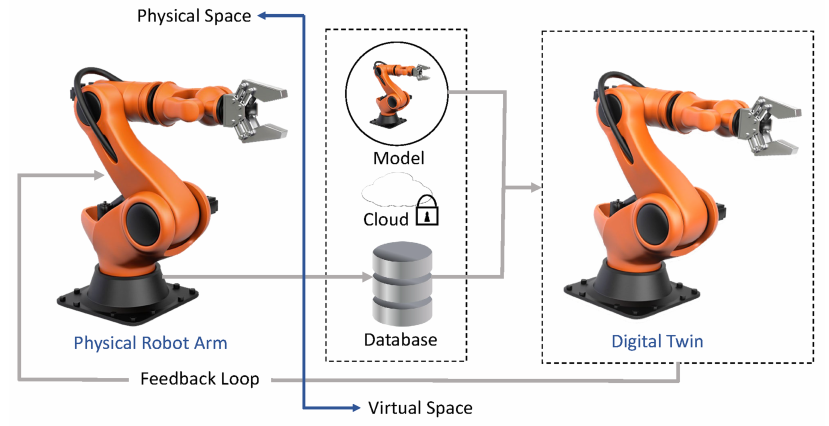
Figure 18. An implementation of a digital